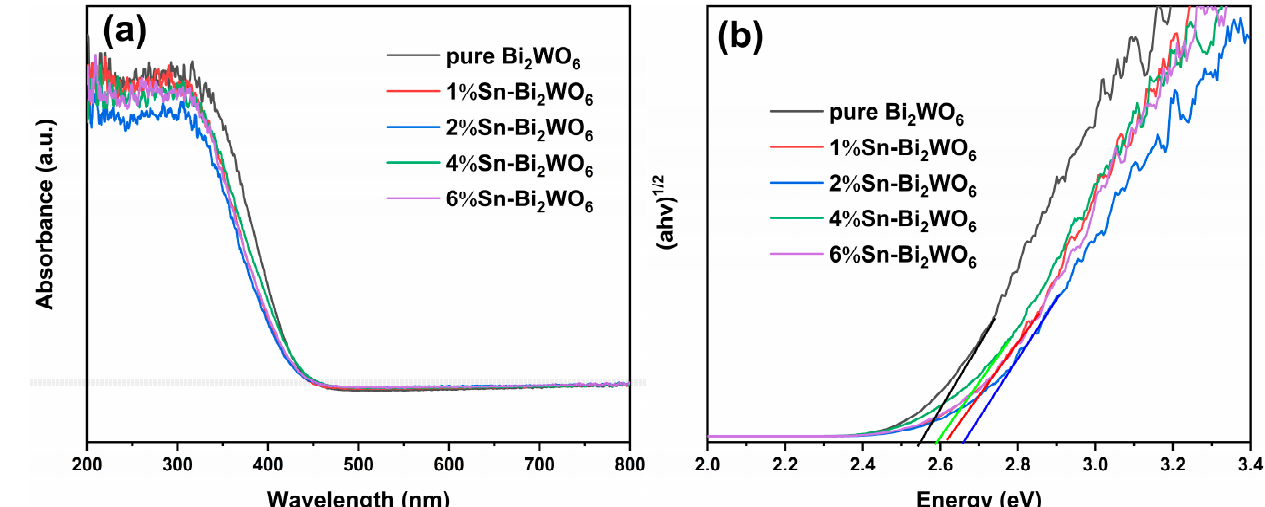
Figure 7. Diffuse reflectance spectra ( a ) and band gap energy ( b ) of samples.